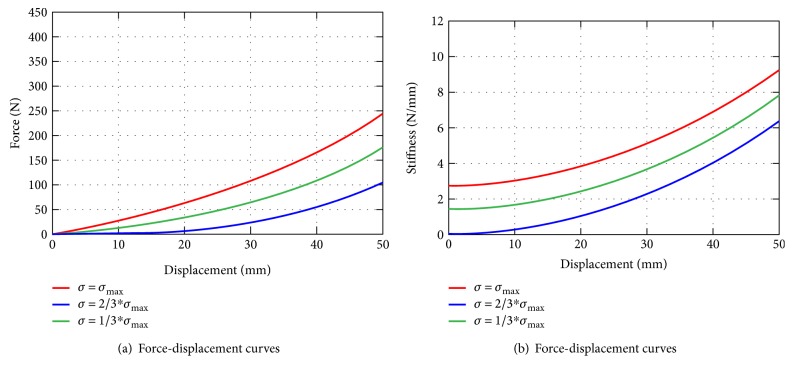
Force- and stiffness-displacement curves with respect to σ = 1/3σmax, 2/3σmax, and σmax.